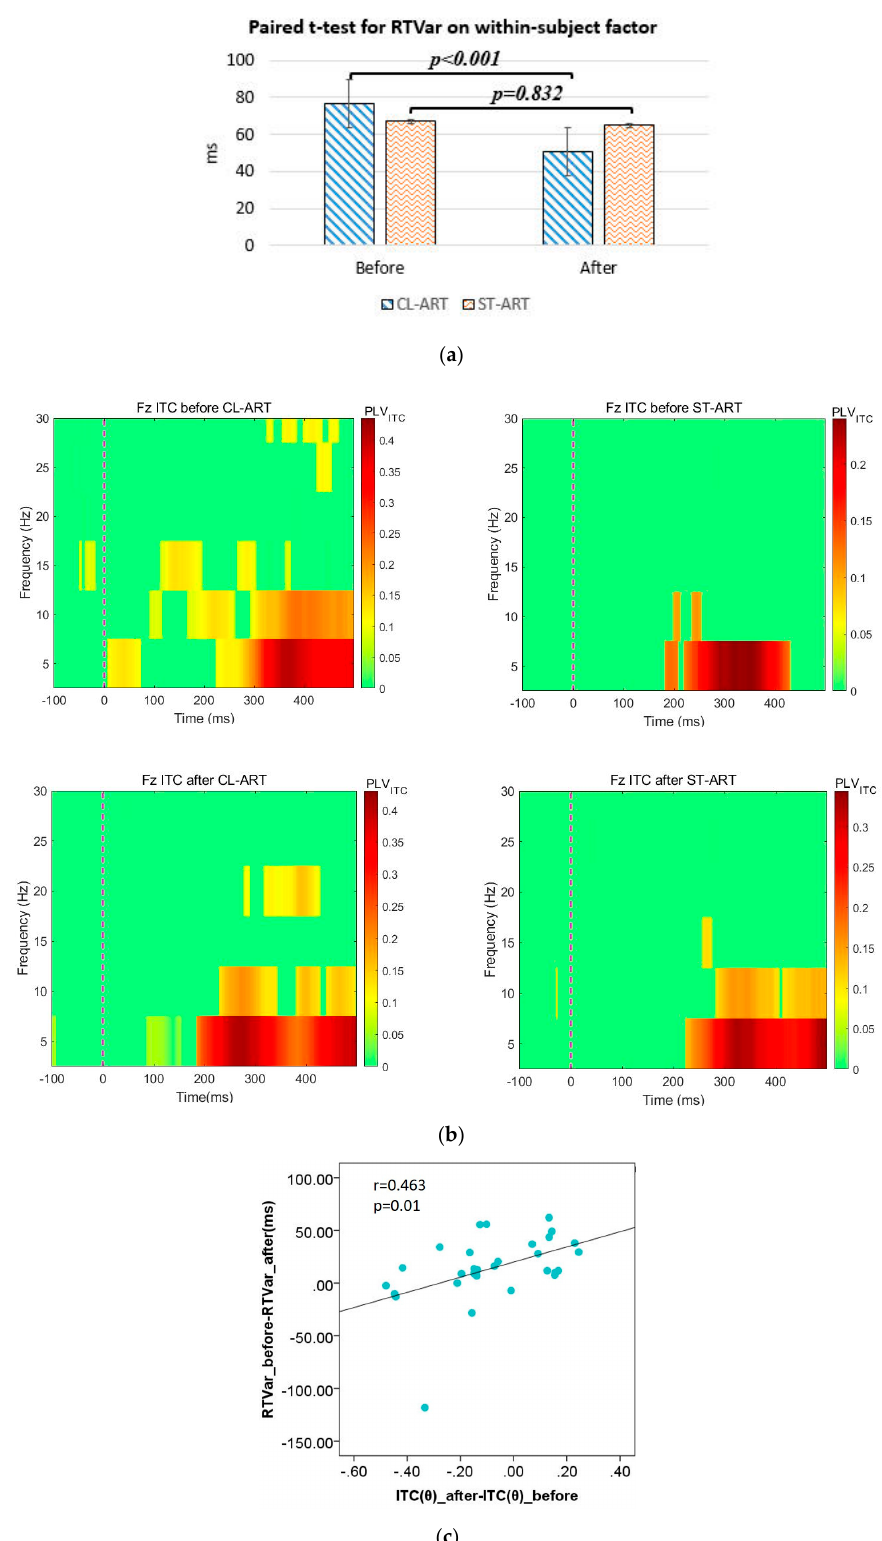
Figure 4. ( a ) Paired t -test and subject means for RTVar; ( b ) the group grand average for ITC captured before and after the two kinds of ART interventions; as can be seen here, the highest phase-locking value (PLV; deep red) in the “after CL-ART” condition occurred in the bin of 200–300 ms, which was clearly faster than that in the bin of 300–400 ms in other conditions; ( c ) scatter plots for RTVar difference and ITC difference. Table 3. Summary of one-way ANOVA analysis results for ITC( θ ) difference.